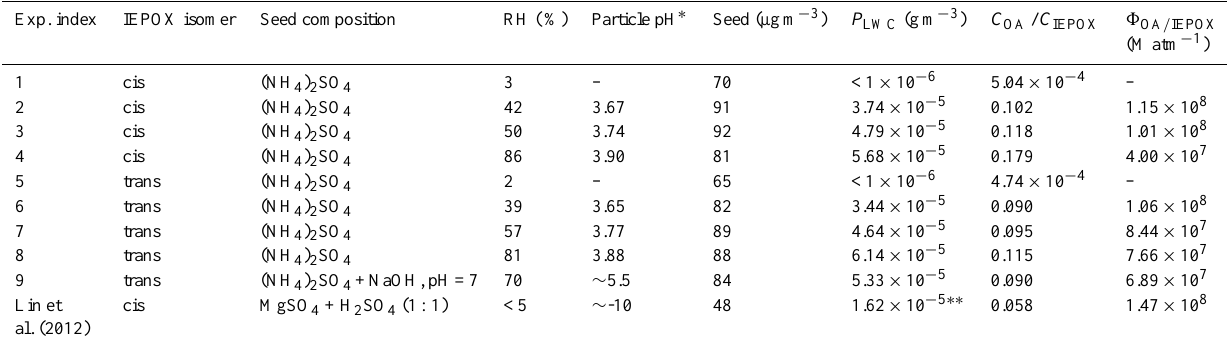
Table 1. Summary of results from representative reactive uptake experiments onto ammonium sulfate seeds. Mean results from Lin et al. (2012) are shown for comparison.